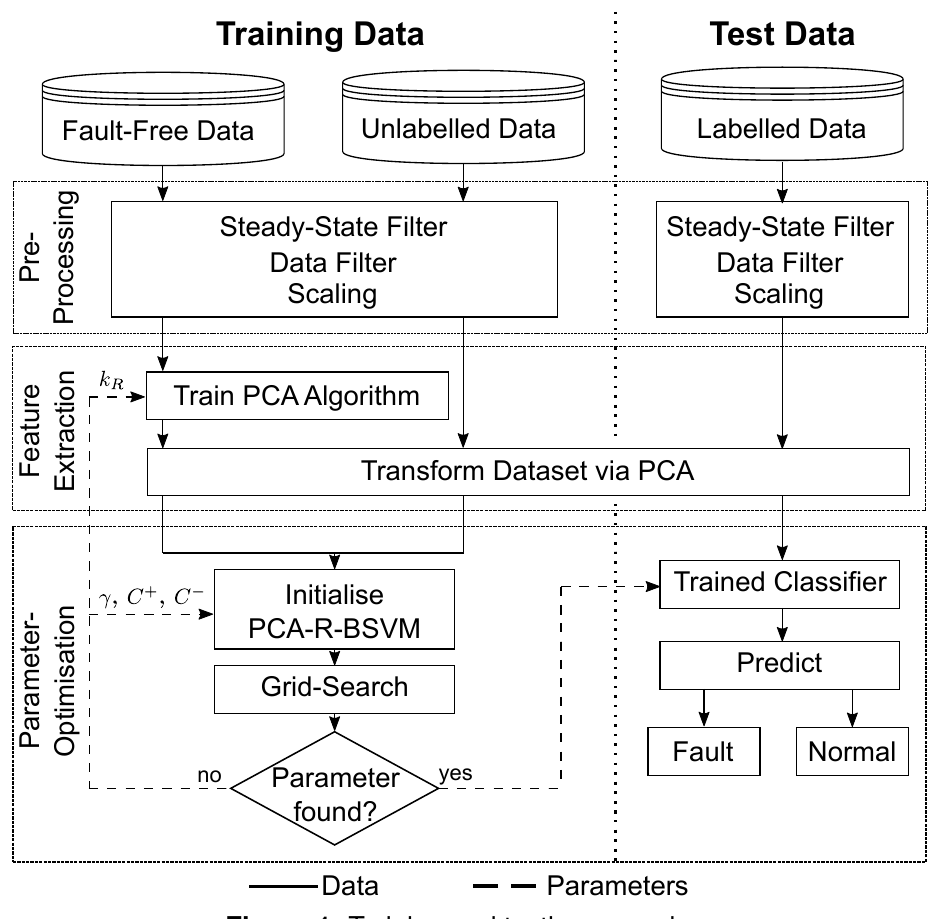
Figure 1. Training and testing